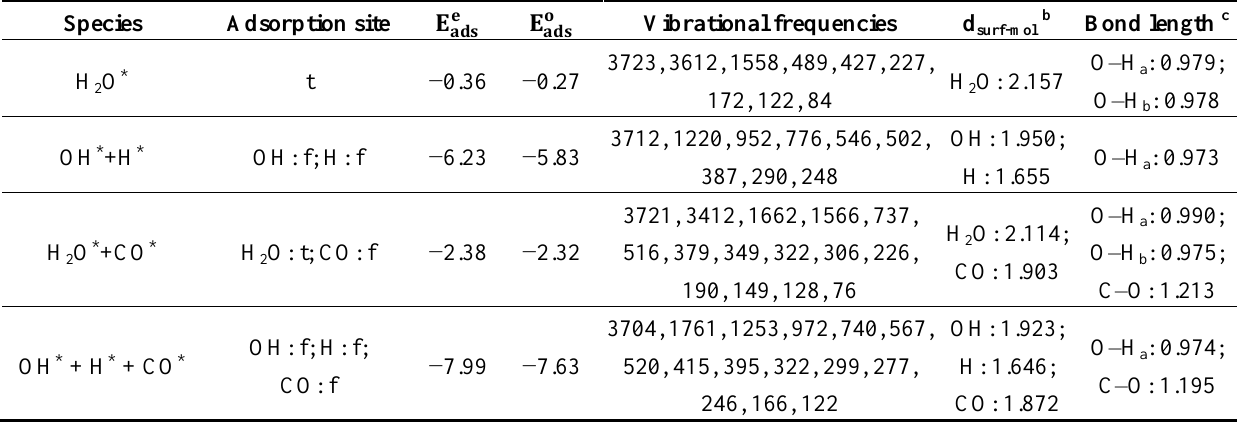
Table 1. Adsorption energies (eV), vibrational frequencies (cm −1 ) and structural parameters (Å) of reactants and products with and without co-adsorbed carbon monoxide. a